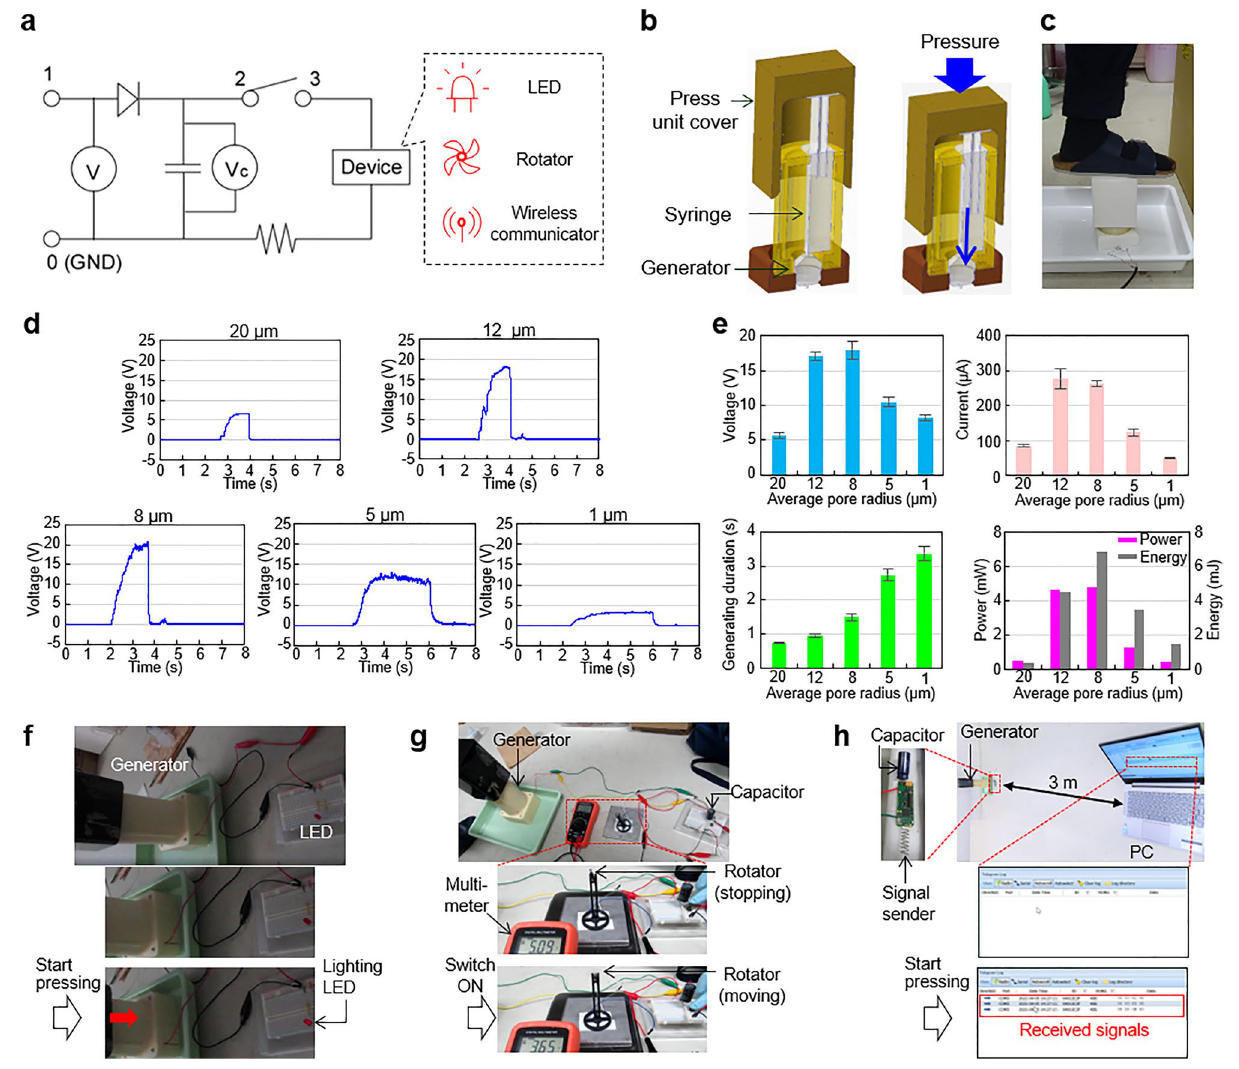
Figure 4. Demonstration and application of the electric power generator equipped with a foot press unit. ( a ) A circuit for capacitor storage and device driving applications. A generator was connected to ports 0 and 1. For energy saving applications, the generator was used without connecting ports 2 and 3. ( b ) Schematic drawings showing the working motion of the foot press unit. ( c ) Photo of the foot press unit. ( d ) Voltage time-courses using porous glass filters sintered at 700 °C with ground glass powder for the average pore radius indicated at the top of each graph. Each graph shows the voltage during 1 pressing cycle using a 60 kg weight (foot pressing by an experimenter) starting at about 2 s. ( e ) Voltage, current, power generating duration, estimated power and energy of the generator versus average pore radius. Voltage and current plots represent average ± S.D. (n = 3). ( f ) Application of direct LED lighting by connecting the LED to the generator (without a switch and capacitor). The upper photo shows the overall setup and the lower 2 photos are before and after foot pressing. ( g ) Application to driving a rotator by saving energy in the capacitor. The upper photo shows the overall setup and the lower 2 photos show the rotator (fan) and the multimeter display screen which gives the accumulated voltage in the capacitor before and after turning the switch on to release the energy in the capacitor. ( h ) Application to a wireless communication tool busing energy stored in the capacitor. After energy accumulation, the communication tool automatically sends a signal to the PC. The top right photo shows the overall setup and the top left photo is an enlarged image of the capacitor and sender. The middle and bottom photos are screen grabs generated by the software to confirm signal receiving and